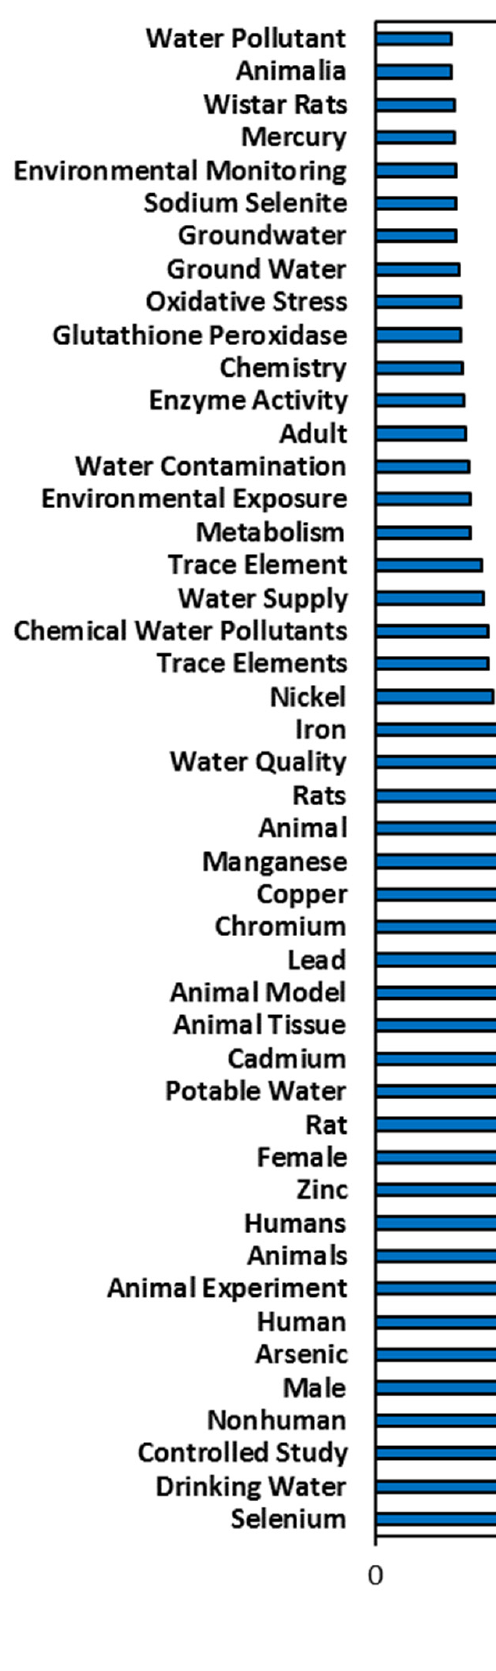
Figure 3. The top 46 most frequently used keywords.